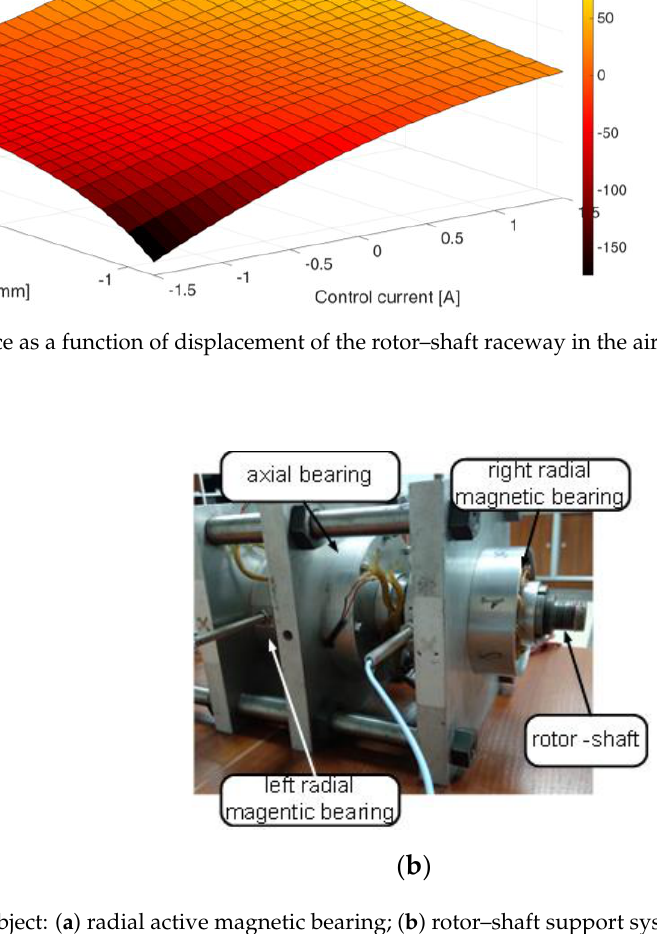
Figure 16. Magnetic force as a function of displacement of the rotor – shaft raceway in the air gap and control current.